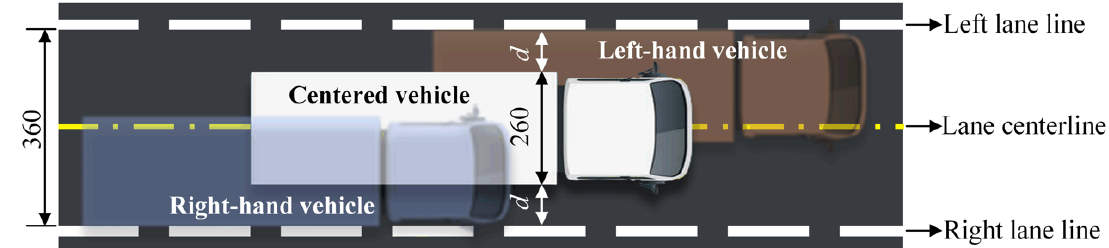
Figure 5. Transverse positions of vehicles within a lane (Unit: cm).